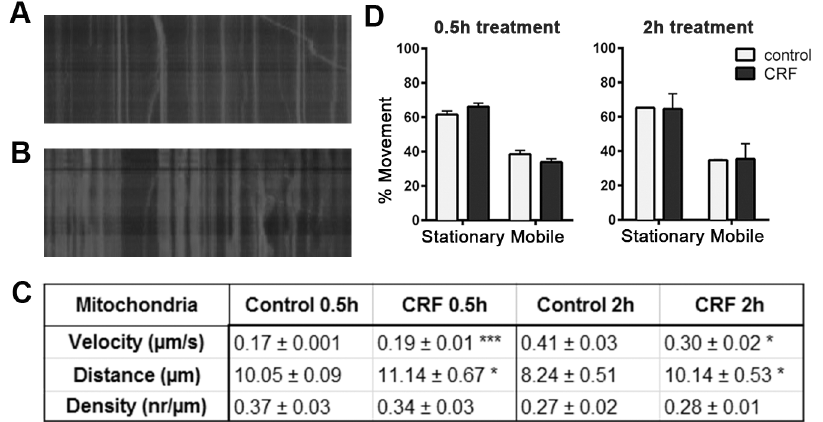
Fig 4. Impact of stress-induced tau-P on mitochondria transport. Kymographs showing axons of cultured mouse hippocampal cells after 2hr treatment; (A) Vehicle control. (B) CRF. (C) Table of quantitative analysis of fluorescent live images acquired from axons of cultured mouse hippocampal cells treated with 10 μ M CRF compared to controls; Average velocity of mitochondria 0.5hr ( *** p = 0.0002), 2hr ( * p = 0.02); Distance travelled 0.5hr ( * p = 0.04), 2h ( * p = 0.01); Density of mitochondria after 0.5hr and 2hr. (D) Percent of mitochondrial movement at 0.5hr and 2hr.